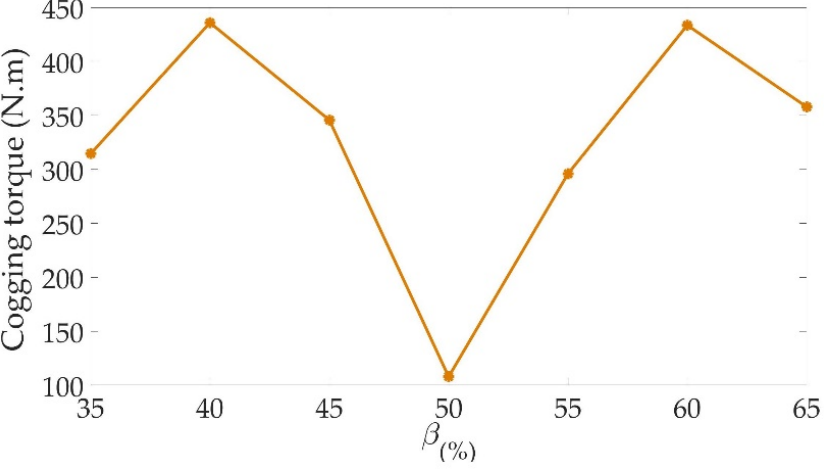
Figure 11. Cogging torque peak-to-peak magnitude for different ratios β ( α = 0%).